Question: Write a caption explaining this figure to a reader.
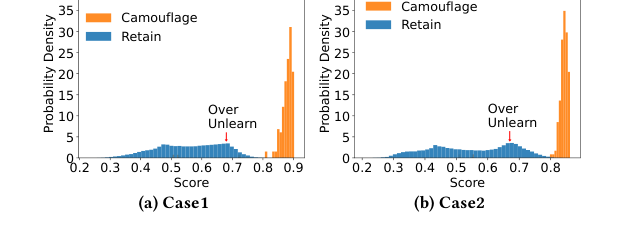
Answer: UnleScores for samples within Camouflage ’Unlearning’ Cases of Texas.